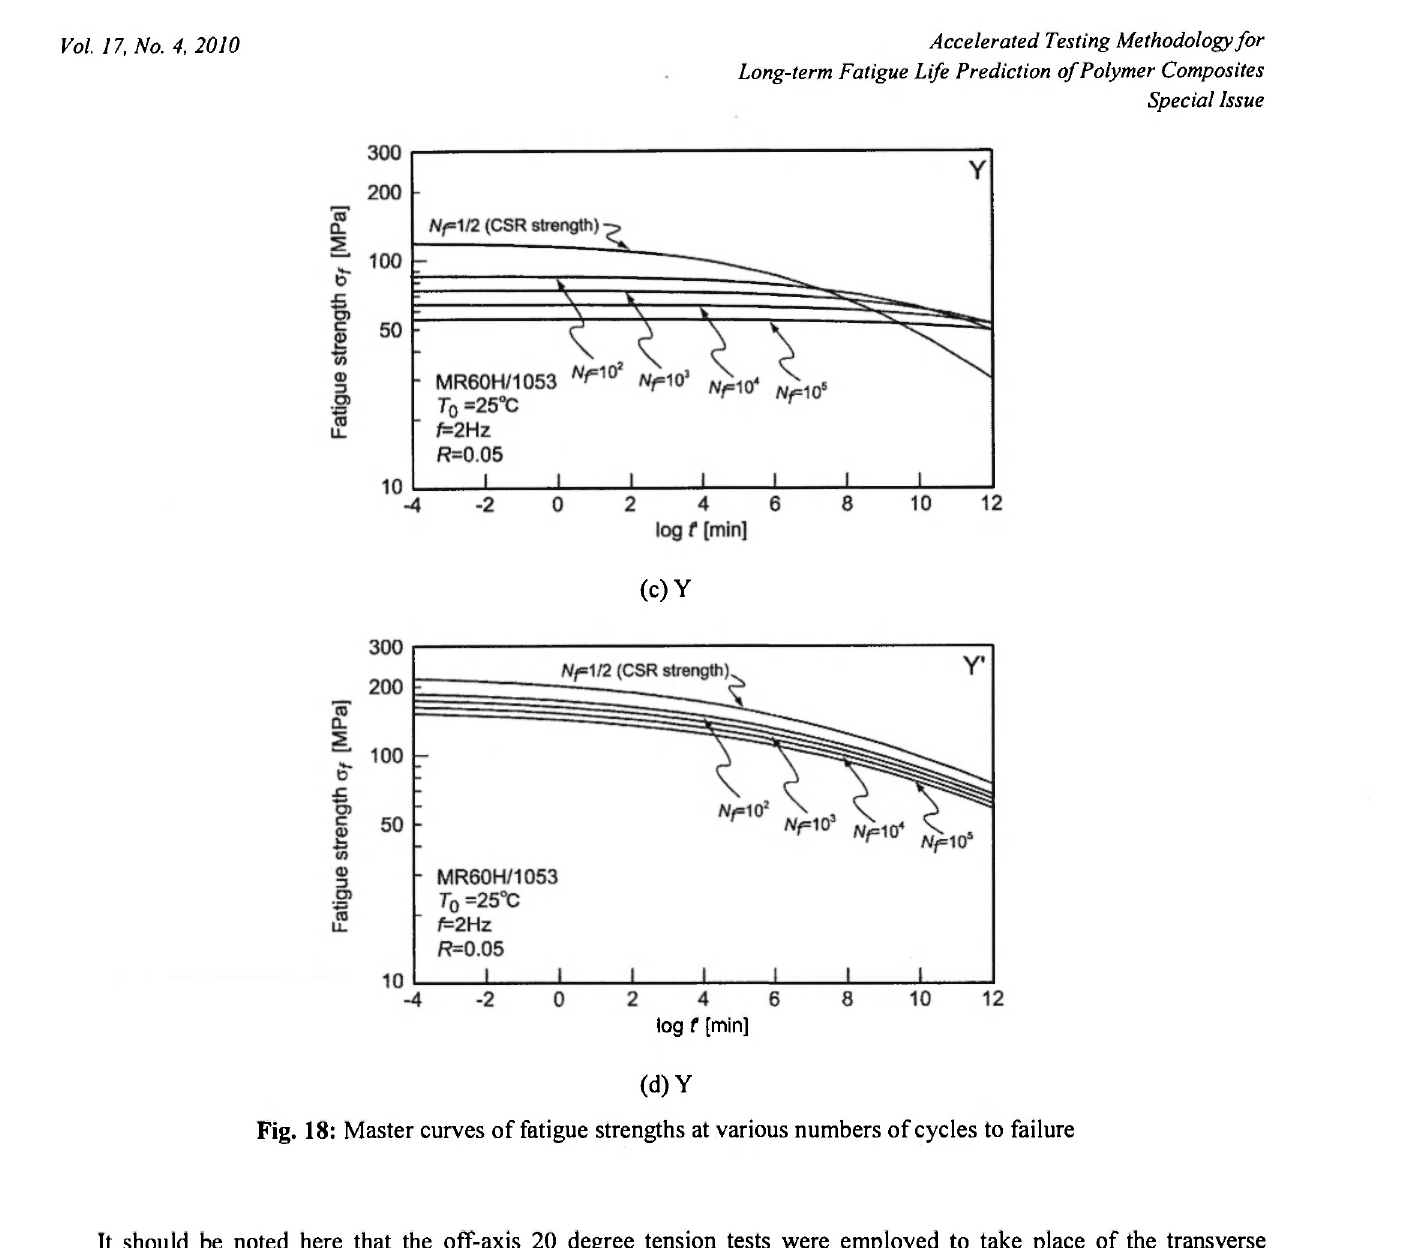
Fig. 18: Master curves of fatigue strengths at various numbers of cycles to